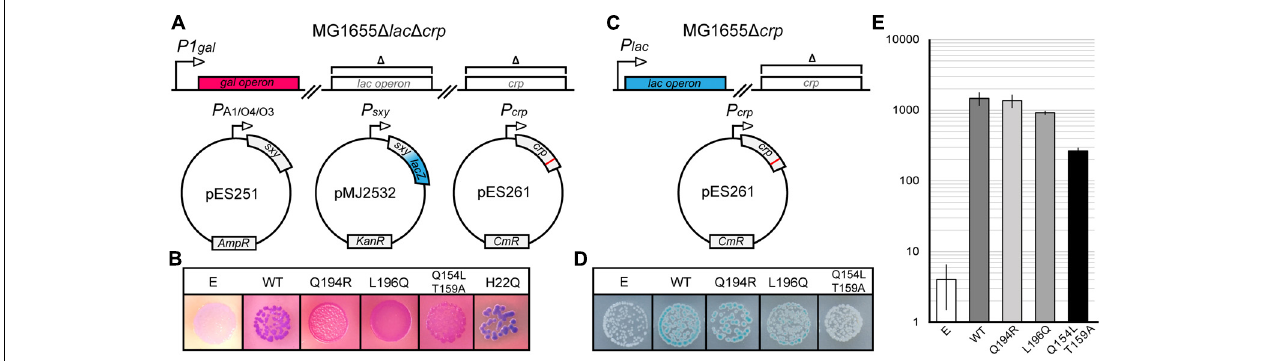
FIGURE 1 | Isolation of CRP mutants defective in activation of CRP-S promoters. (A) Schematic overview of the experimental setup for isolation of CRP mutants with a reduced ability to induce CRP-S sites. The crp coding sequence was mutated by error-prone PCR in plasmid pES261 and mutants were screened in MG1655 (cid:49) lac (cid:49) crp cells (Jaskolska and Gerdes, 2015) carrying plasmids pMJ2532 (Jaskolska and Gerdes, 2015) and pES251 (for Sxy production). Galactose fermentation (red color) was used as a control for CRP function (activation of Class II promoters) and the LacZ reporter in pMJ2532 (blue color) was used to assess activation of Sxy dependent promoters. (B) Phenotypes of CRP mutants on MacConkey galactose X-gal plates. Cells carrying an empty vector (E, p15A) are white because none of the reporters are activated in the absence of CRP, while cells carrying wild-type (WT) crp are purple as both promoters are active. Cells with CRP mutants Q194R, L196Q, and Q154L T159A appear red, indicating galactose fermentation but no LacZ production. CRP H22Q has the opposite phenotype. (C) Schematic overview of the setup used to assay the activation of the Class-I P lacZ promoter. The native lac operon of MG1655 (cid:49) crp is used as a reporter in the presence of plasmids borne CRP mutants. (D) Activation of the chromosomal Class I ( P lacZ ) promoter by CRP mutants defective in the activation of CRP-S promoters. The plasmid borne AR1 CRP mutant Q154L T159A is not able to activate the lacZ promoter, and cells are white on X-gal plates. Cells containing WT CRP, CRP(Q194R), or CRP(L196Q) appear blue. (E) Quantification of chromosomal lac Z expression in the presence of CRP mutants Q194R and L196Q. Cells were grown in M9 medium containing glycerol (0.8%) and Casamino acids (0.2%) in a shaking incubator at 37 ◦ C. β -Galactosidase assays were performed as described previously (Miller, 1972). Results shown are the averages of measurements of three biological replicates. Error bars indicate ± 1